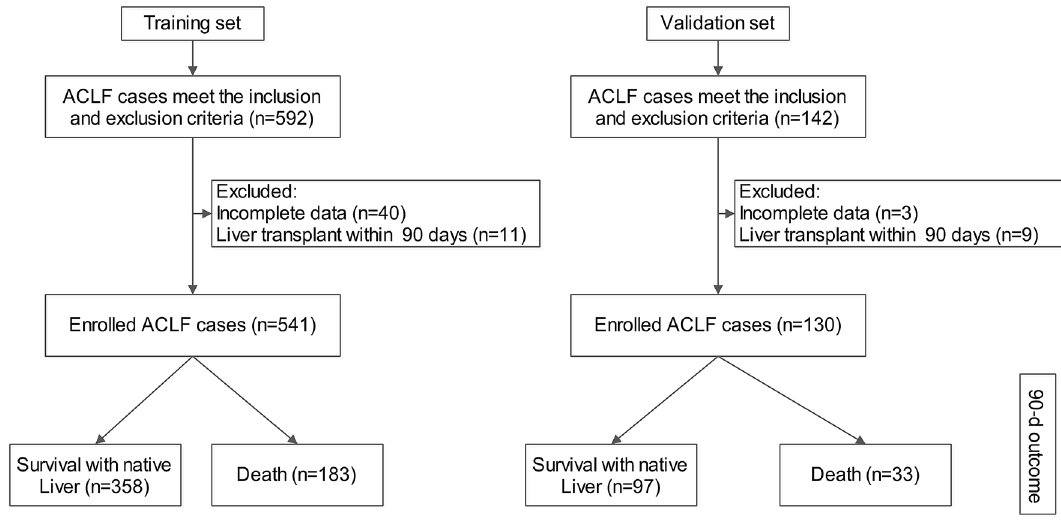
Figure 1. Flowchart of ACLF training and validation group cases